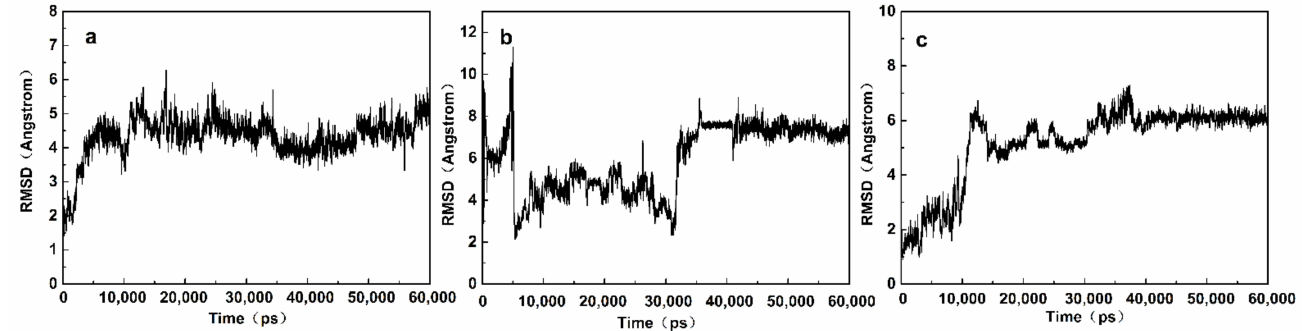
Figure 2. RMSD curve of ( a ) the SBA40-1 aptamer/SQX complex, ( b ) the SBA24-1 aptamer/SQX complex, and ( c ) the SBA28-1 aptamer/SQX